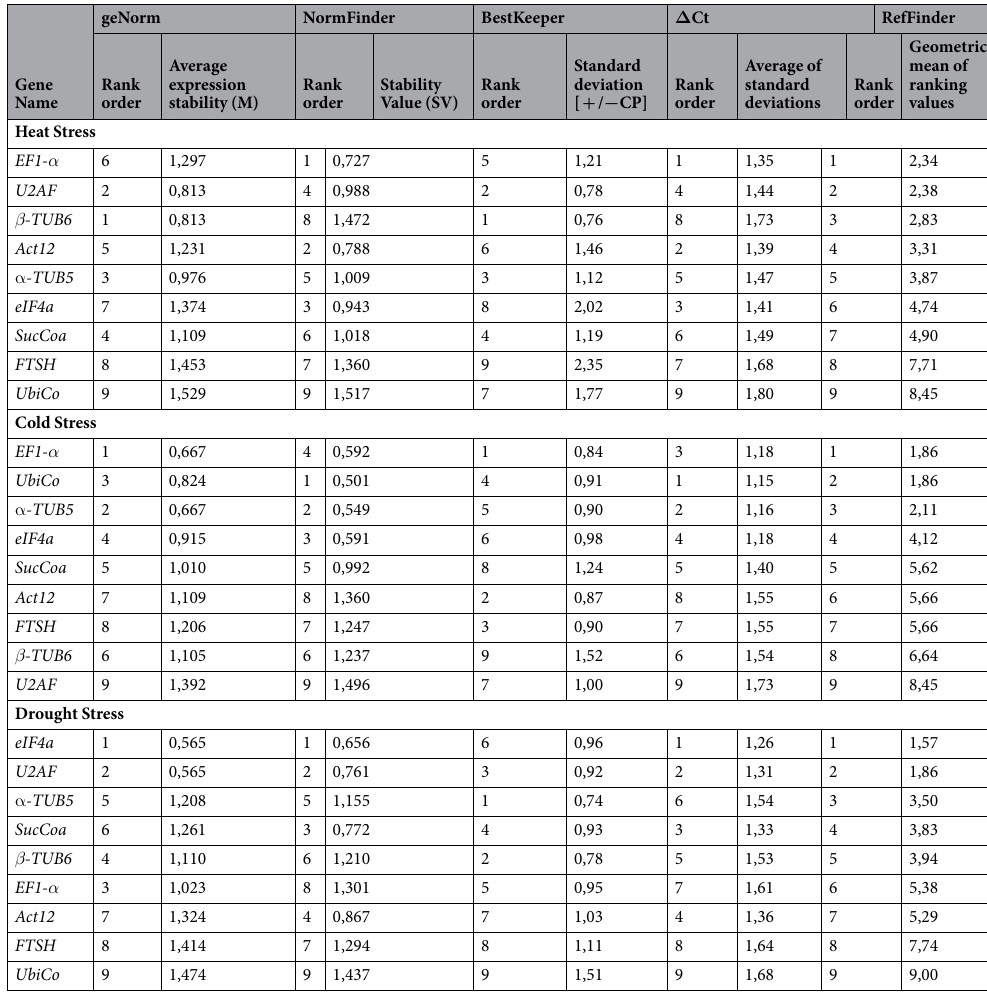
Table 2. Ranking of candidate reference genes according to stability values in a pool of Urochloa brizantha leaves samples subjected to various abiotic